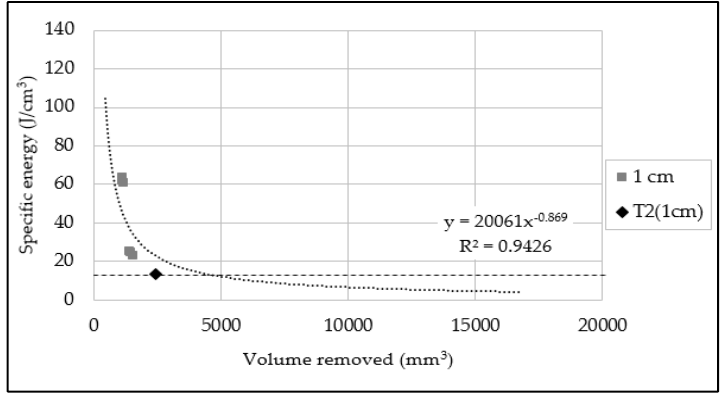
Figure 14. Calculation of optimum energy in concretes with a c/s ratio of 1:1.